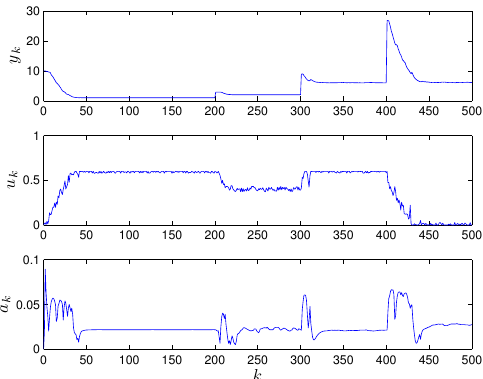
Figure 3. Performance of the anti-windup PIESC for Example 1. The top plot shows the progression of the cost function. The corresponding input variable is shown in the middle plot. The bottom plot shows the resulting amplitude of the dither signal.